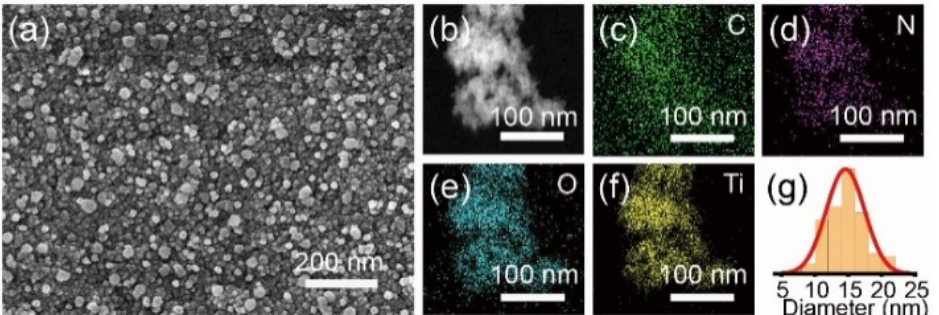
Figure 1. ( a ) SEM, ( b ) TEM, ( c – f ) EDS mapping, and ( g ) histogram of particle size distribution of C 60 ‐ EDA/TiO 2 composite.